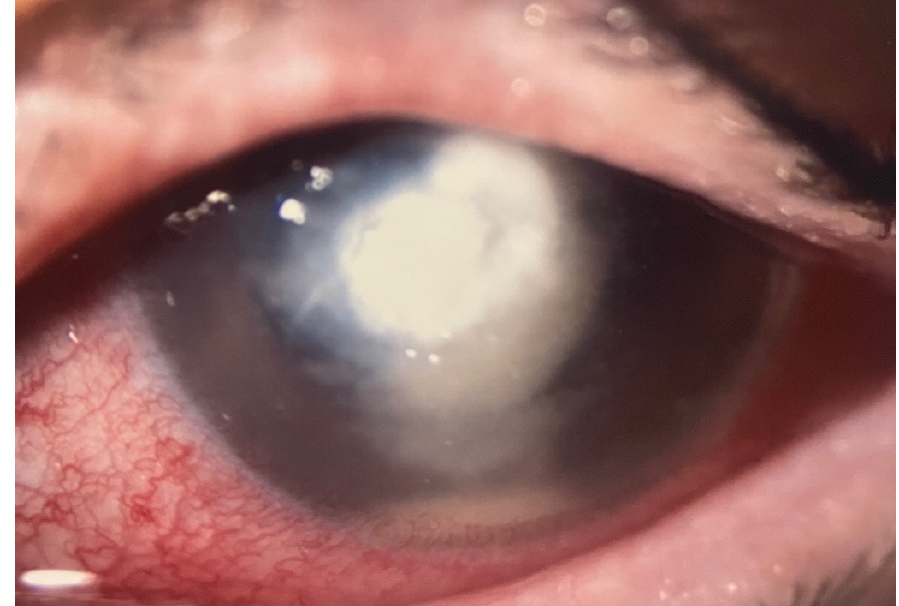
Figure 2. Biomicroscopic slit-lamp photography of the left eye before the first keratoplasty with significant expanded infiltration penetrating all corneal layers and intrusion in the anterior chamber.